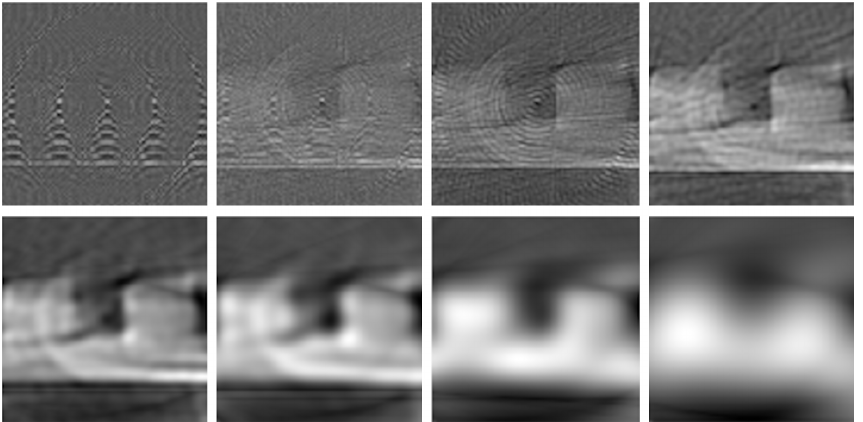
Figure 8. Different filter configurations showing different image reconstructions for the Two Squares model—from wider ( upper-left ) to narrower ( down-right ) pass band filter by changing the lock-in amplifier parameters. Narrower bands reduce the noise and the artifacts, but also the sharpness in the contour of the